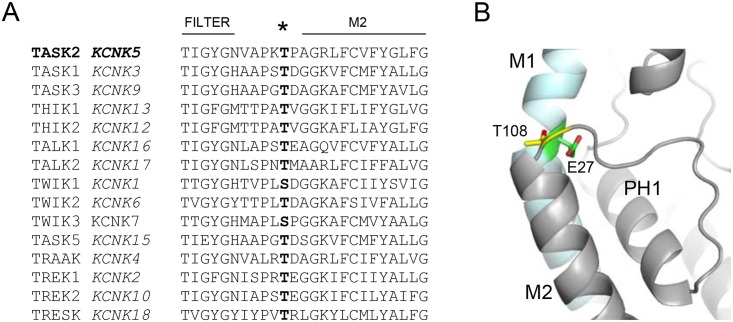
Structural modelling of the T108P variant.(A) Amino acid sequence alignment of the selectivity filter to M2 region containing the T108P variant for all 15 members of the human K2P family of K+ channels showing the highly-conserved nature of the mutated residue. T108 is indicated by an asterisk. (B) Homology model of TASK-2 created using the crystal structure of TREK-2. This reveals that T108 is located at the top of the M2 helix in the loop that connects M2 to the selectivity filter. T108 (yellow) on M2 hydrogen bonds with the backbone and side chain of E27 (green) located on the adjacent M1 helix (cyan).